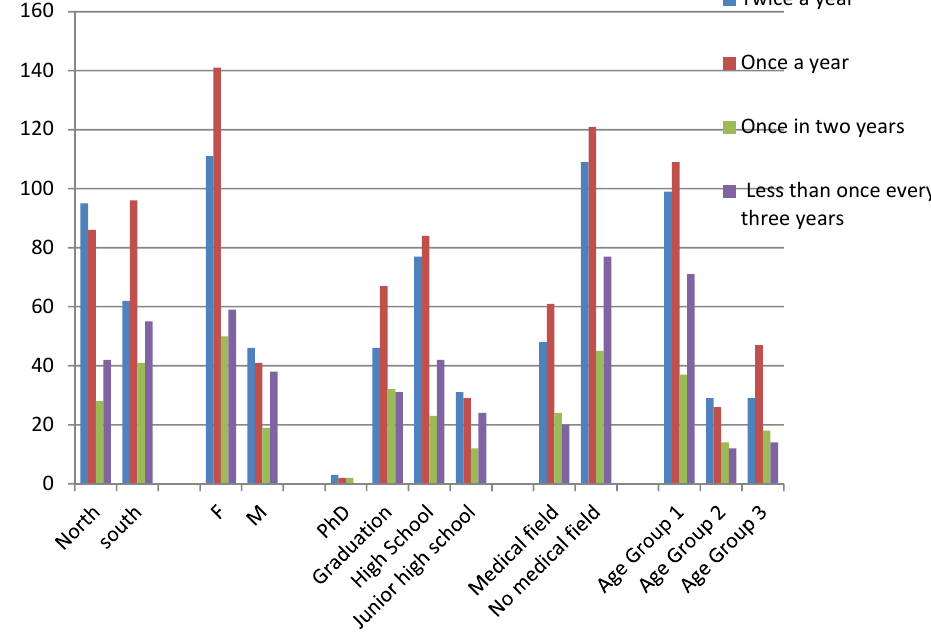
Figure 8. Answers about habits of routine dental